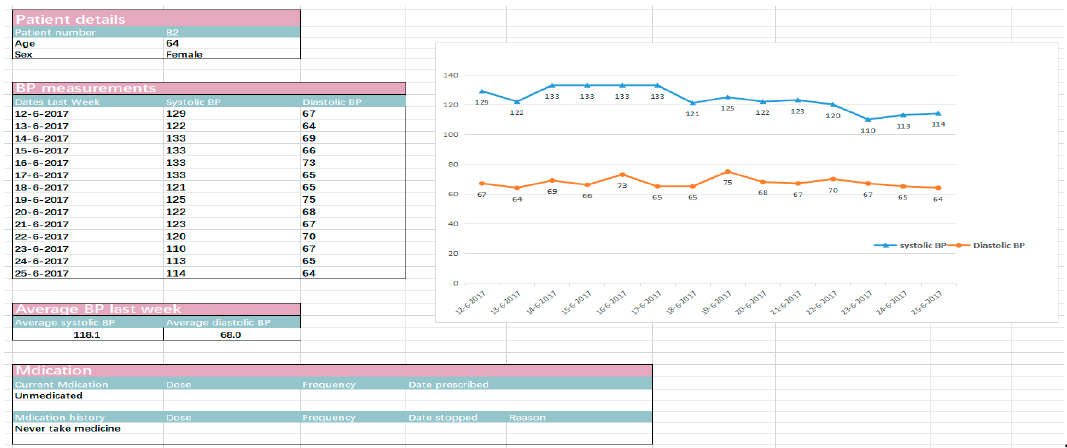
Figure 1. Overview of the dashboard.